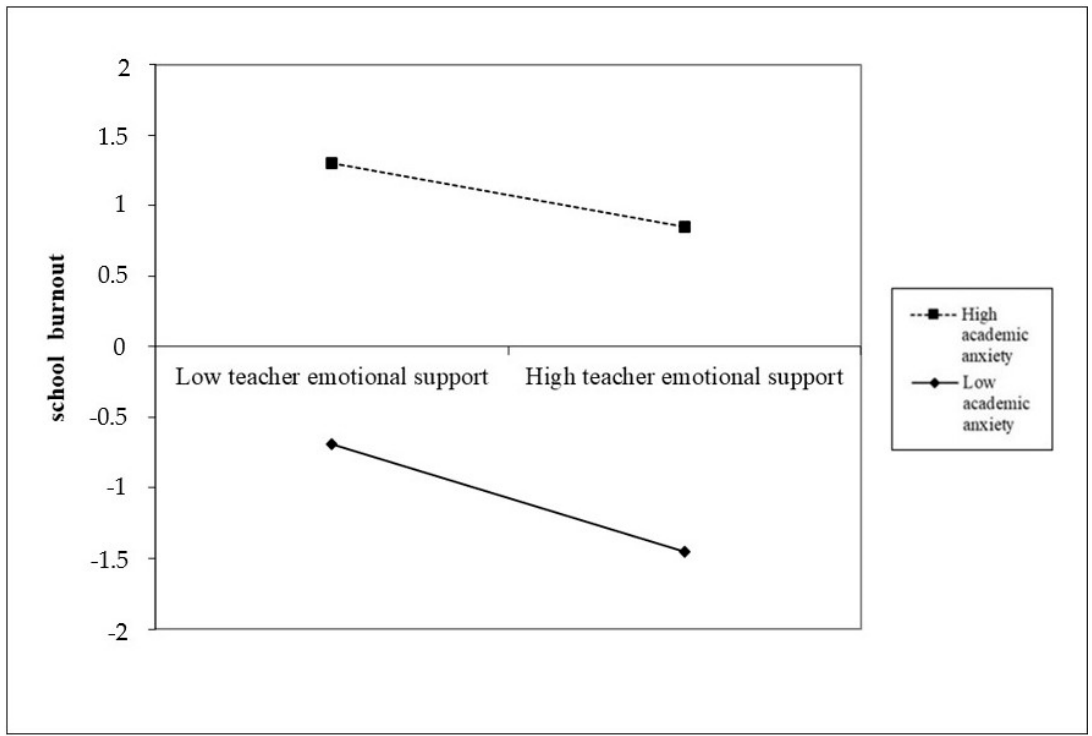
Figure 2. Latent interaction of teacher emotional support and academic anxiety on school burnout. Note. High academic anxiety = + 1 standard deviation (SD); low academic anxiety levels = − 1 standard deviation (SD).